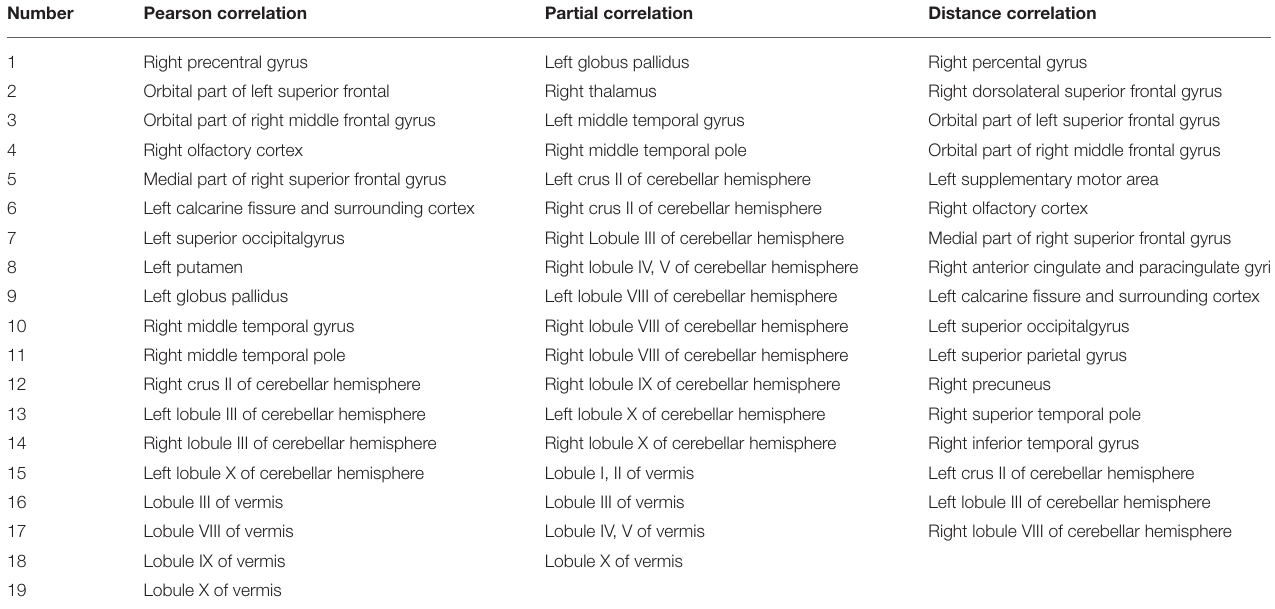
TABLE 5 | The most discriminative brain